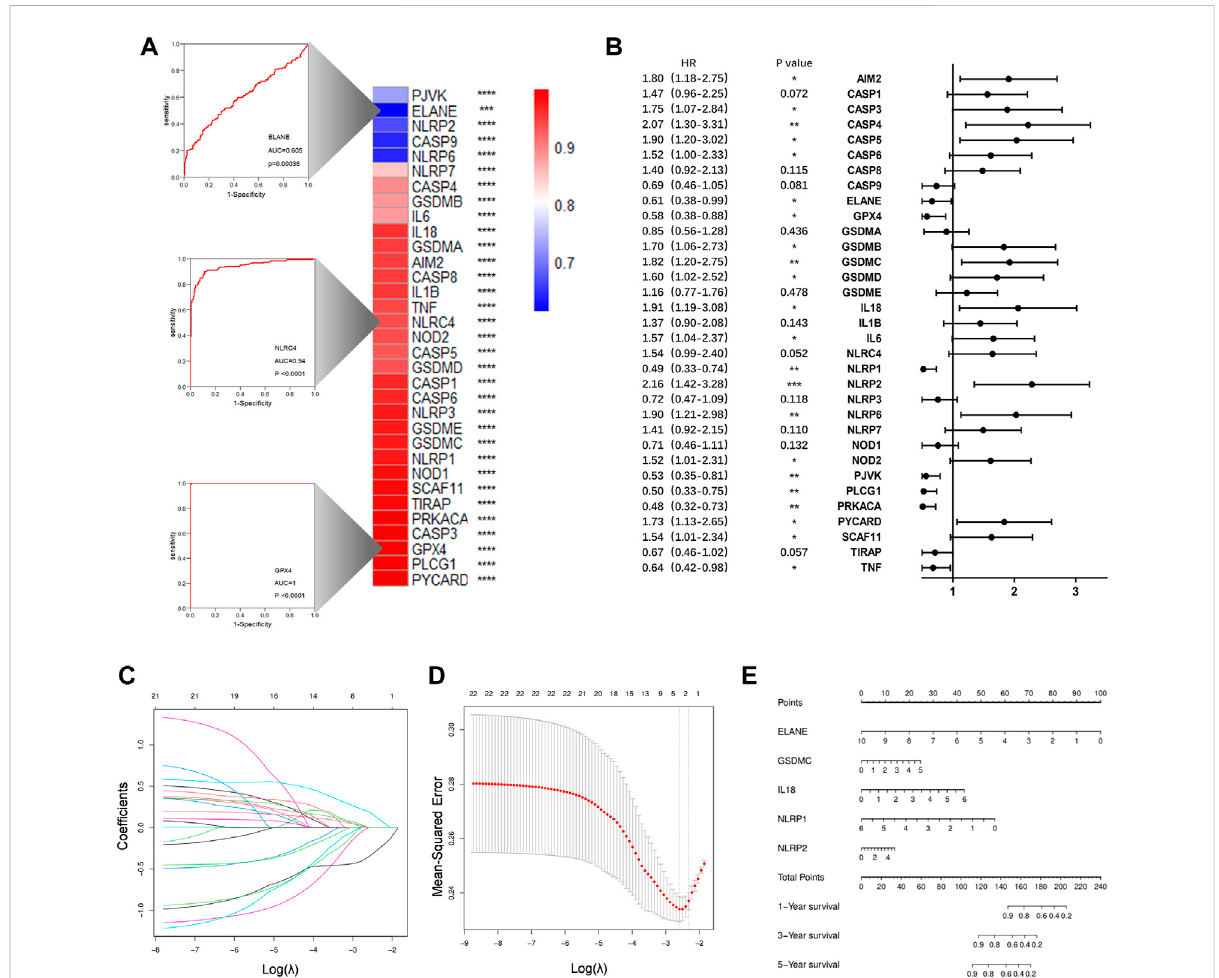
FIGURE 4 Construction of a prognostic prediction model. (A) Heatmap to show AUC values for each PRGs. Three example ROC curves are displayed on theleft. (B) Hazardratiosanalyzed via univariatecoxregressiontoevaluatetheprognosticabilityforeachPRGs. (C) LASSOcoef fi cientpro fi leofPRGs. (D) Ten times cross-validation for parameter selections in the LASSO cox regression. (E) The nomogram incorporating 5 selected PRGs. * p < 0.05, ** p < 0.01, *** p < 0.001, **** p <